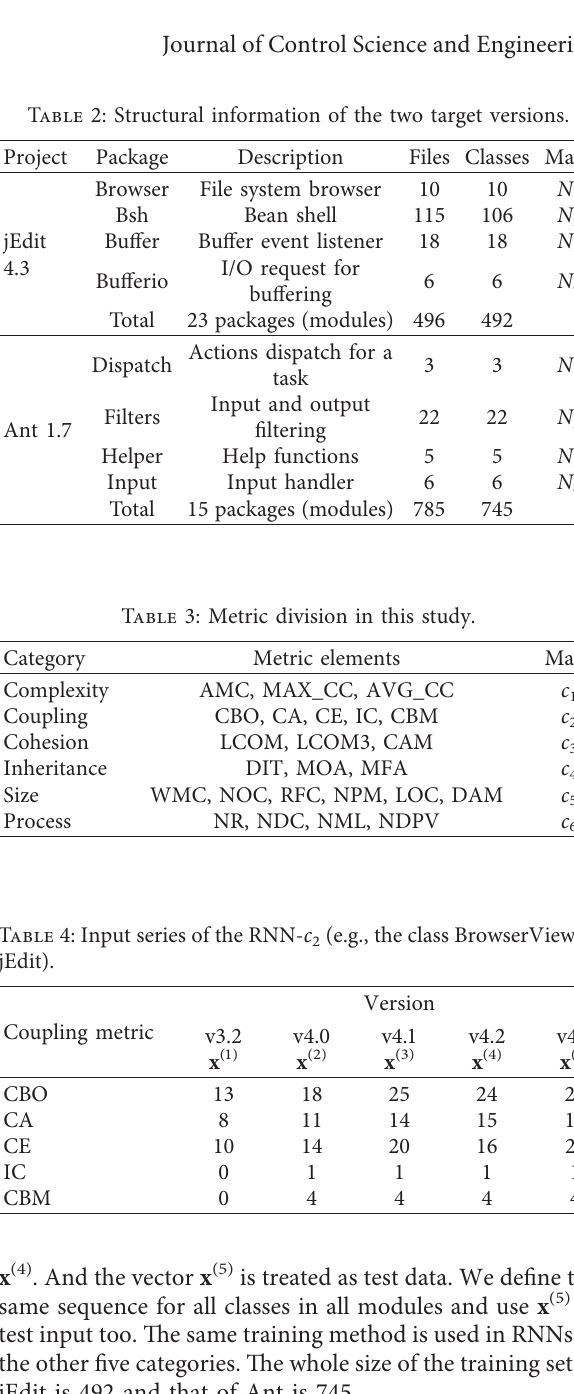
Table 2: Structural information of the two target versions.